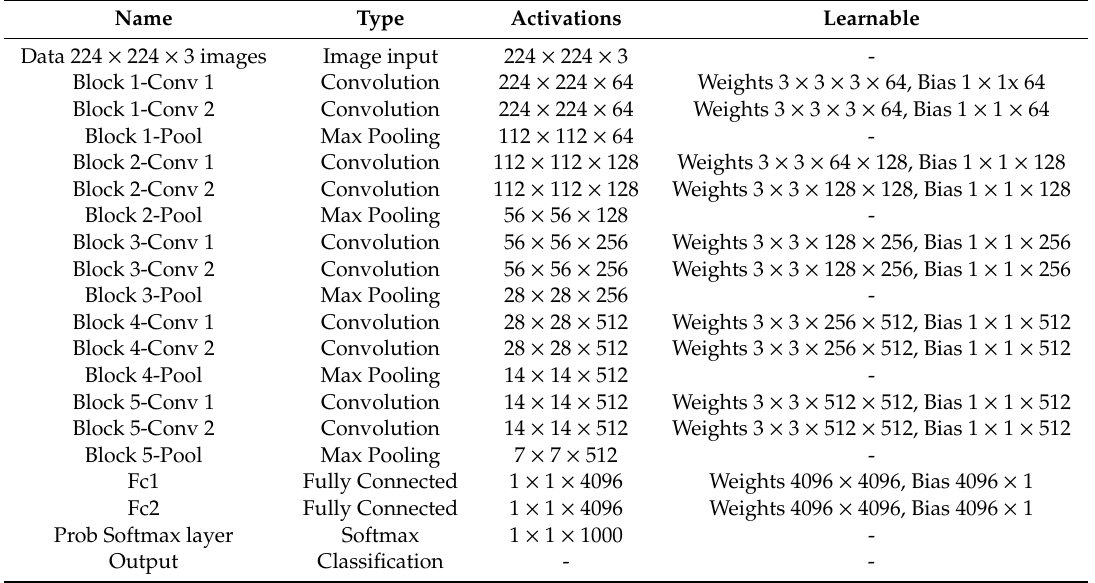
Table 6. VGG-16 architecture hyperparameters.